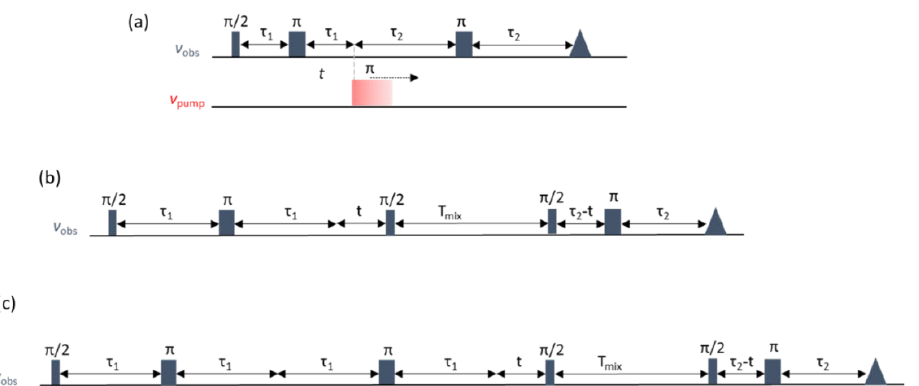
Figure 1. PDS sequences used in the study: ( a ) 4-pulse DEER, ( b ) 5-pulse and ( c ) 6-pulse RIDME. In DEER and RIDME, the dipolar coupling is measured with pulses applied at two or one microwave (mw) frequencies, respectively. In DEER, one set of spins is monitored on the observe frequency ( ν obs ), while another set of spins is flipped on the pump frequency ( ν pump ) (Figure 1a). If the distance to be measured involves two different types of spin centers, e.g., one paramagnetic metal ion (Cu II , Gd III , Mn II with electron spin S = 1/2, 7/2, 5/2, respectively) and one organic radical (nitroxide or trityl radical, S = 1/2) the pulses are placed to observe one type of spin, while flipping the other type of spin. In order to obtain high effective sensitivity, one typically pumps the NO or trityl spin that exhibits narrow EPR spectrum, while observing the paramagnetic metal ion (see a comparison of their EPR linewidths in Table S1, Supplementary Materials). In RIDME, one type of spin is observed in the frequency ν obs , while the other type of spin is let to flip spontaneously by its longitudinal relaxation during the time interval T mix [9] (Figure 1b,c). Therefore,